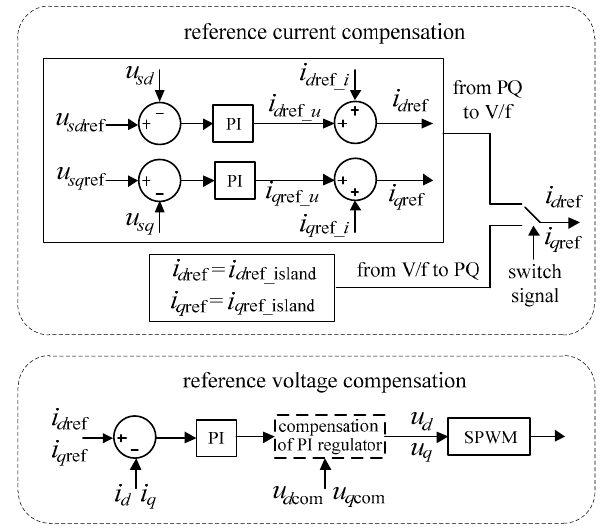
Figure 5. The compensation strategy for the main DC/AC converter.